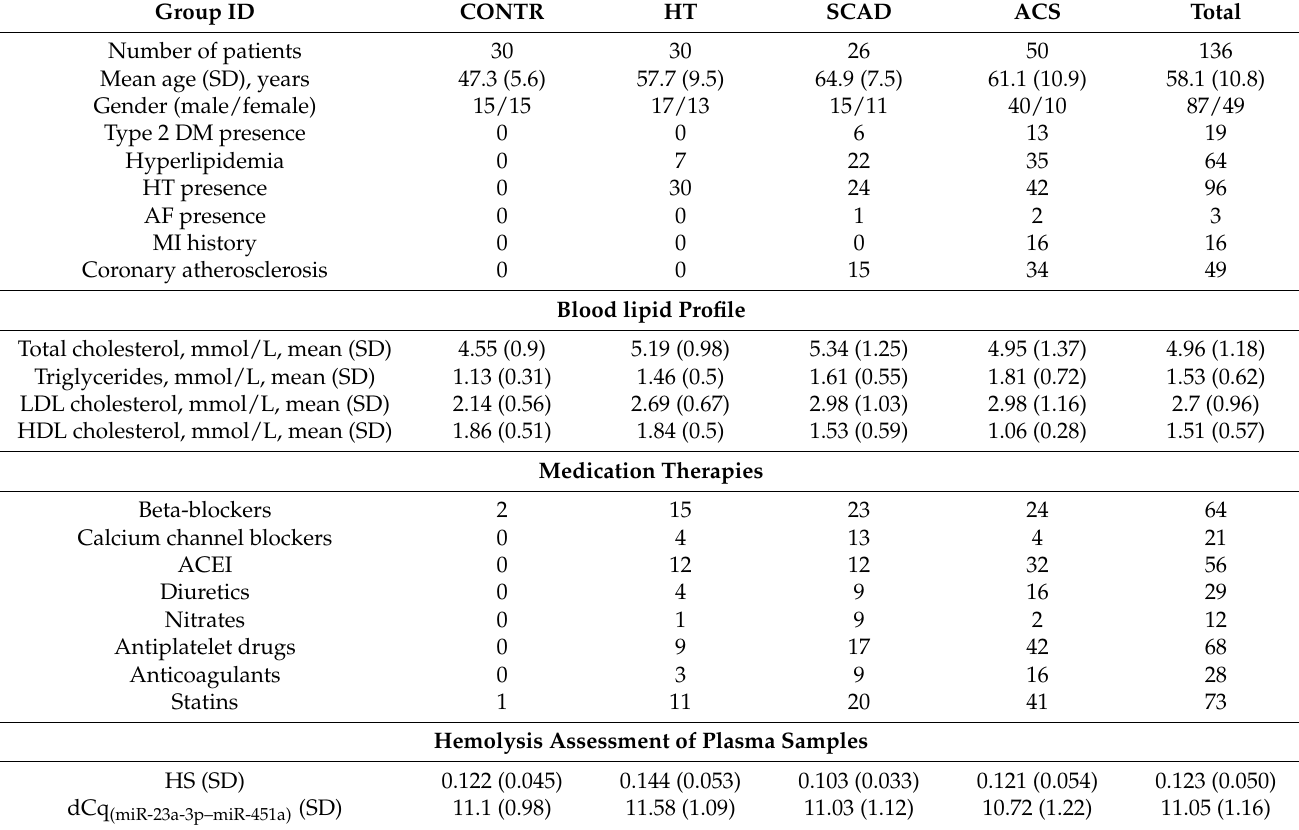
Table 2. Characteristics of the study sample groups. CONTR, 30 healthy controls; HT, 30 hypertensive patients without CAD; SCAD, 26 patients with stable CAD; ACS, 50 patients with acute coronary syndrome (26 with unstable CAD and 24 with MI); CAD, coronary artery disease; MI, myocardial infarction; SD, standard deviation; HT, hypertension; DM, diabetes mellitus; AF, atrial fibrillation; ACEI, angiotensin-converting enzyme inhibitors; LDL, low-density lipoproteins; HDL, high-density lipoproteins; HS, hemolysis